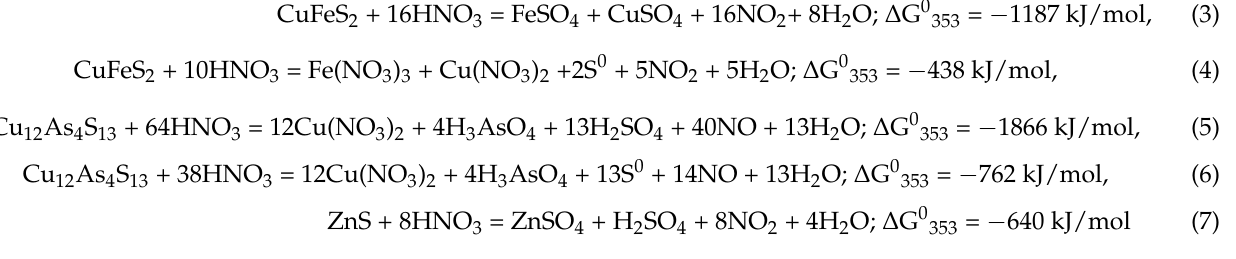
( c ) Figure 2. Effect of temperature on the conversion of Cu 12 As 4 S 13 ( a ), CuFeS 2 ( b ), ZnS ( c ). (300 rpm; 6 mol/L HNO 3 ; 0.018 mol/L Fe (III); FeS 2 /synt. conc = 1/1). According to the conversion profiles, the progress of the reaction was observed to